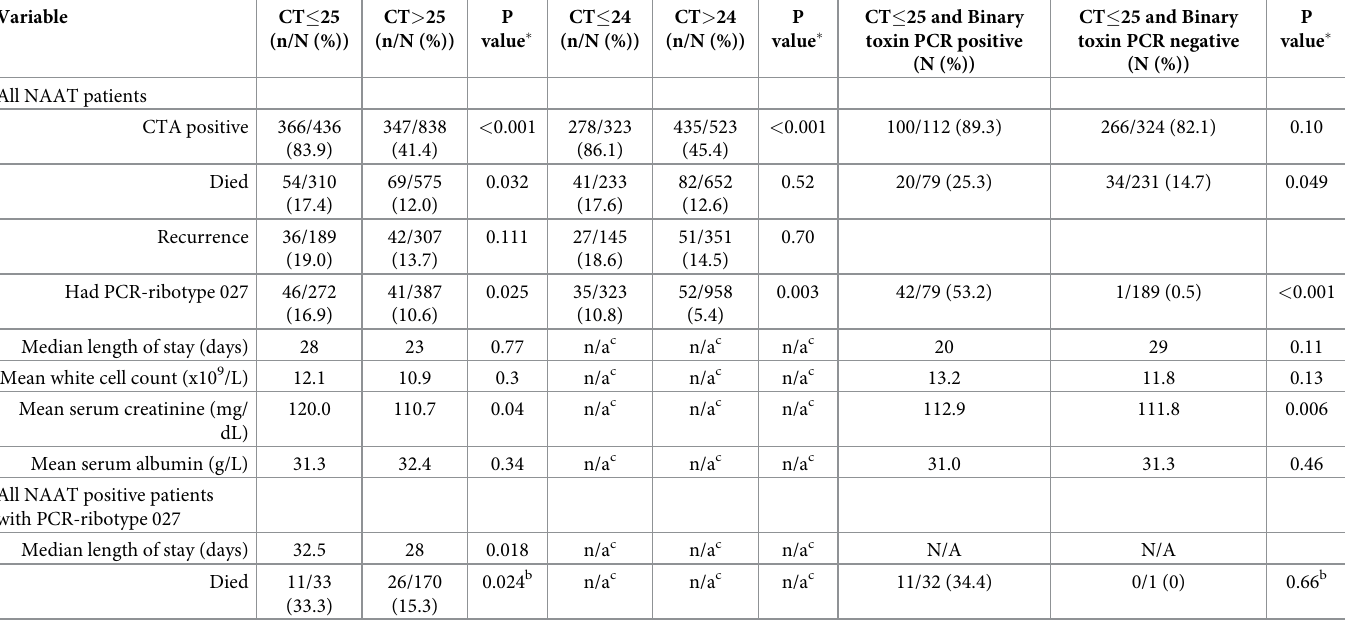
Table 1. Outcomes and severity markers for patients with CT values � 25 or > 25.